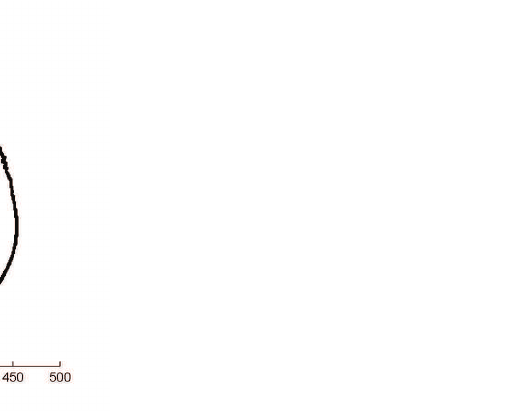
Figure 18. Construction of fractured part curve using GC 1 rational Ball curves with three segments.